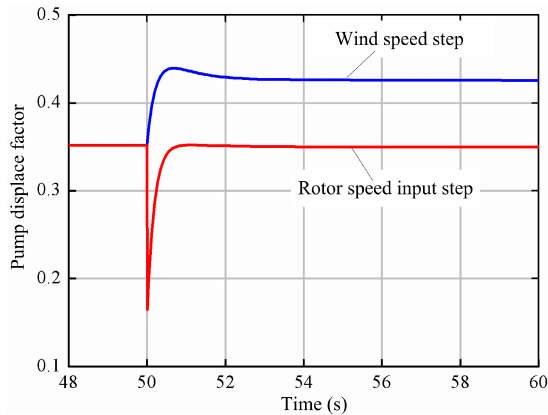
Figure 9. Pump displacement factor.